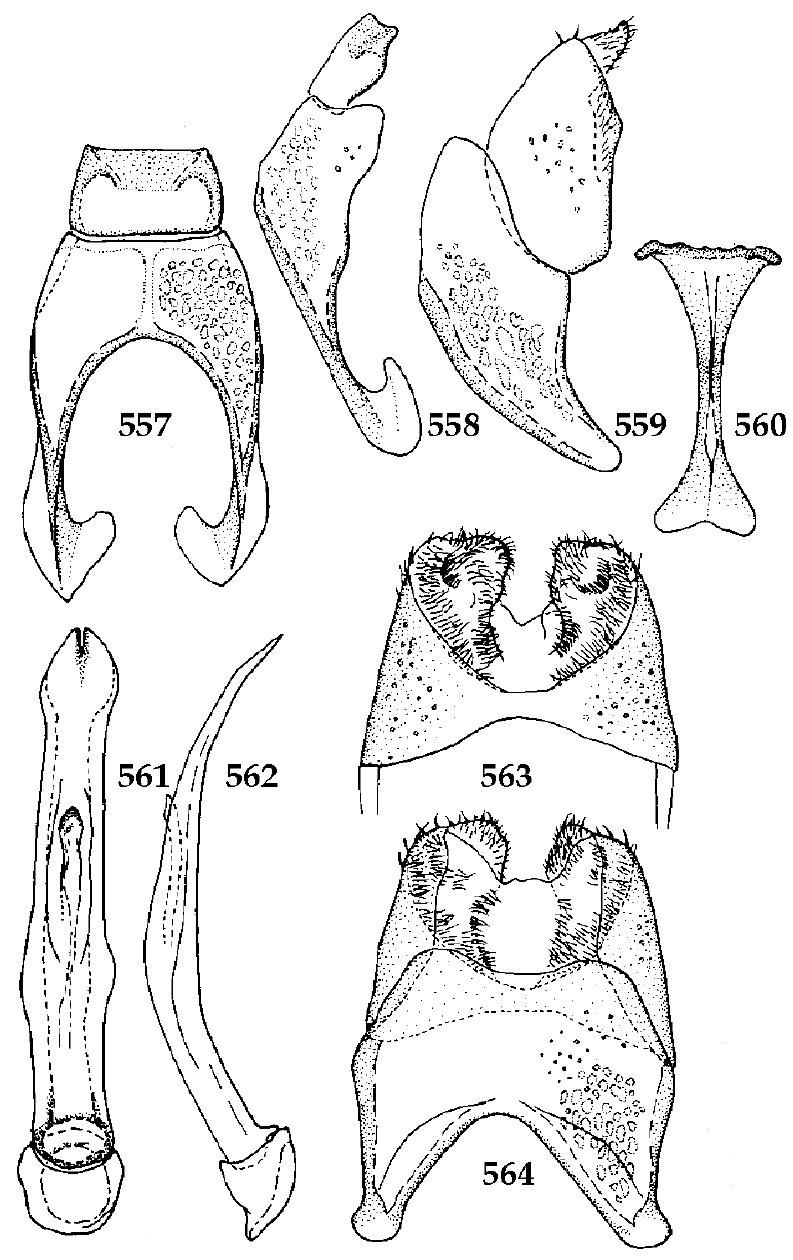
Figures 557–564. 557 Saprinus ( Saprinus ) splendens (Paykull, 1811) male terminalia after Ôhara (1994): 9 th + 10 th tergites, dorsal view 558 ditto, lateral view 559 male terminalia: 8 th sternite + 8 th tergite, lateral view 560 male terminalia: spiculum gastrale, ventral view 561 male terminalia: aedeagus, dorsal view 562 ditto, lateral view 563 male terminalia: 8 th sternite, ventral view 564 male terminalia: 8 th ster- nite + 8 th ventrite, dorsal